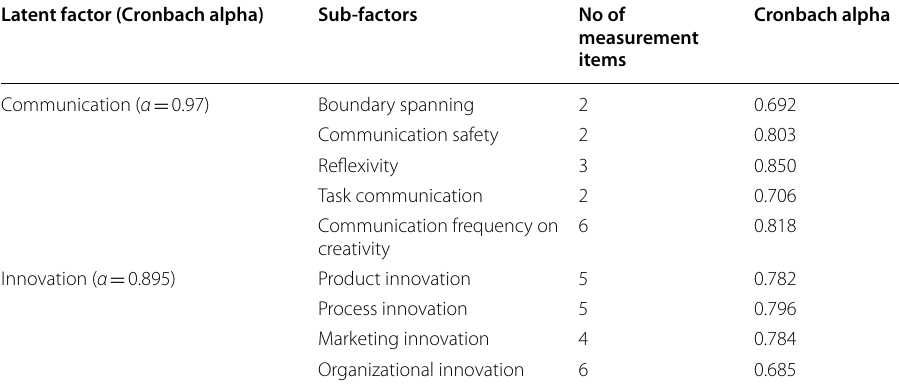
measurement items